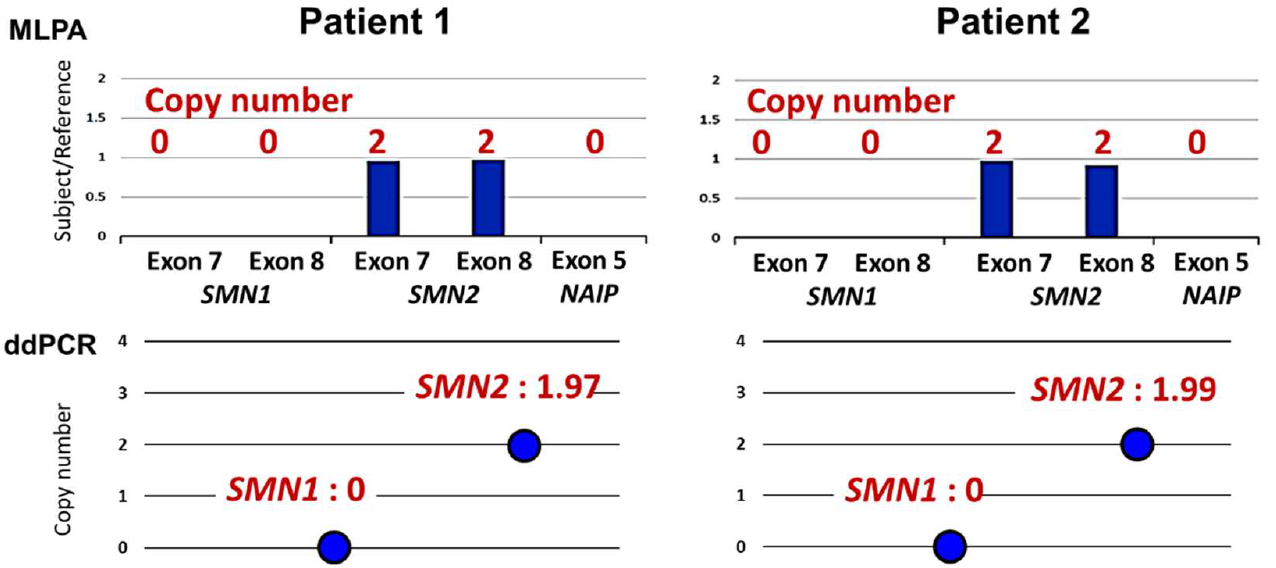
Figure 3. Clinical courses of Patients 1 and 2. Patient 1 may have been symptomatic at birth and diagnosis of SMA might have been delayed. However, the patient was treated with nusinersen at 24 days of age. Then, onasemnogene abeparvovec was administered at 4 months of age (19 weeks of age). The patient has made modest motor improvements since treatment initiation with a 32-point improvement in CHOP-INTEND score (12-point before treatment to 44-point at 24 weeks). Patient 2 was treated pre-symptomatically. These patients remain under observation. CHOP-INTEND: The Children’s Hospital of Philadelphia Infant Test of Neuromuscular Disorders. Patient 1 was a 6-month-old female infant who was diagnosed with symptomatic SMA type I. She was born in April 2022. She was the first child of non-consanguineous healthy parents. The parents had no family histories of neuromuscular disorders. Her clin- ical information related to SMA diagnosis and treatments is summarized in Table 4 and Figures 2 and 3. During pregnancy, there were no notable episodes in the mother and infant. How- ever, after the expected date of birth, induced vacuum-assisted vaginal delivery was needed because of severe variable deceleration. The infant’s gestational age was 41 weeks